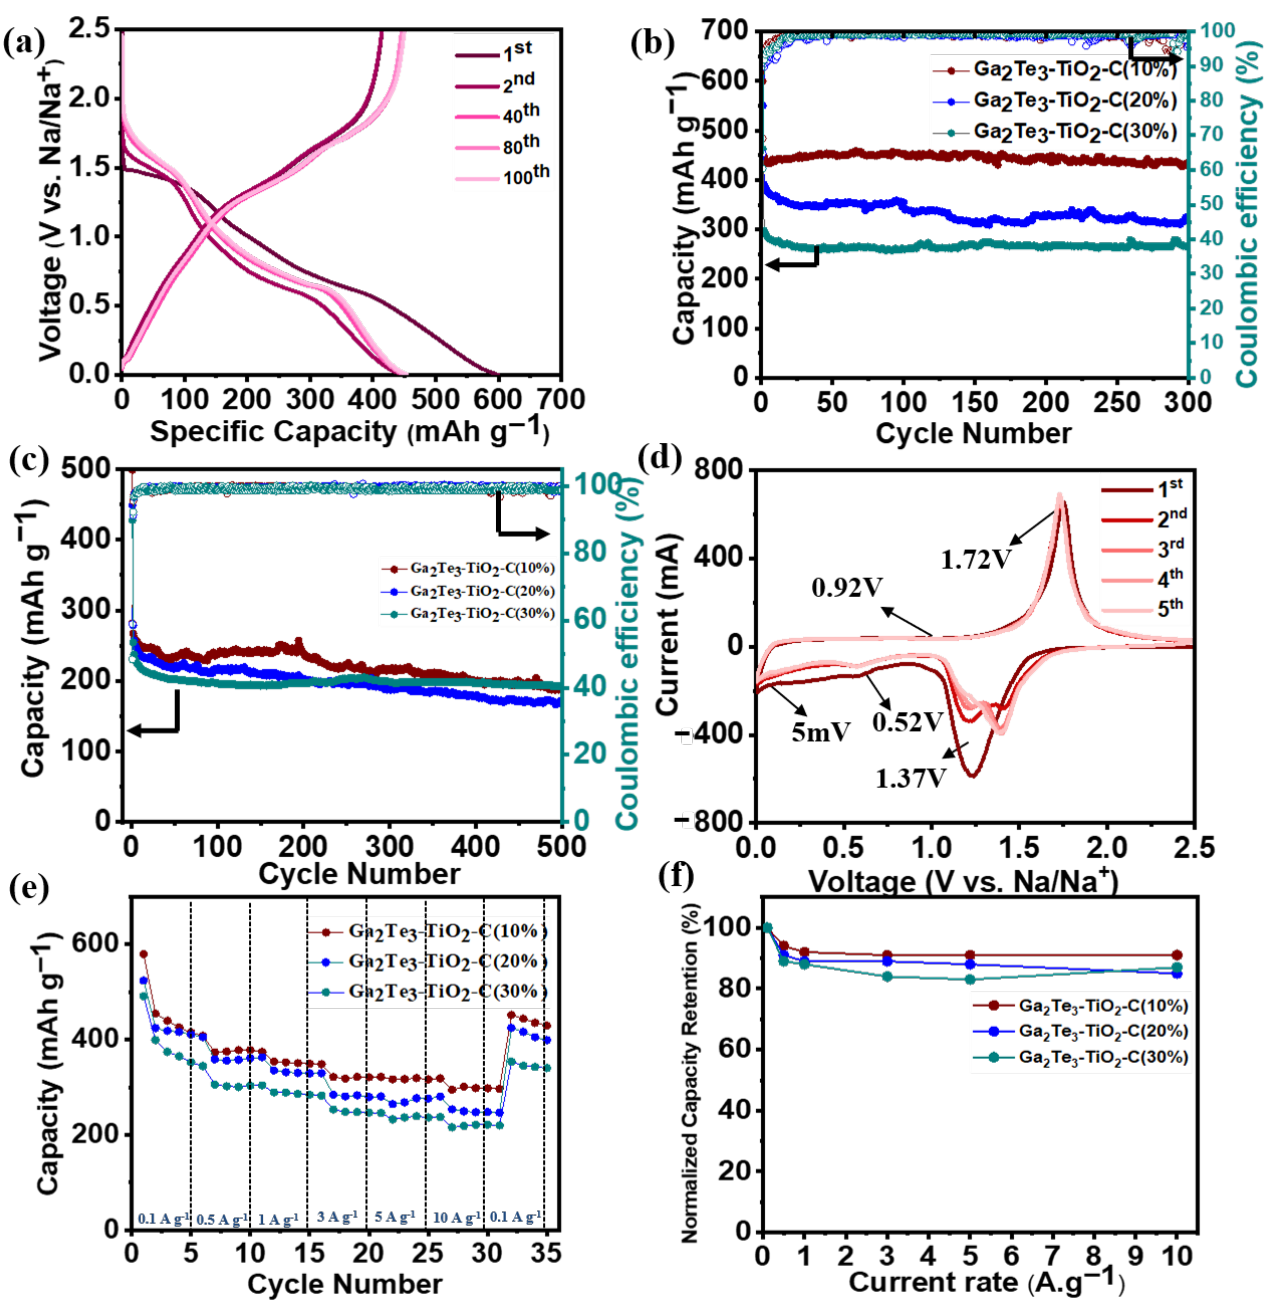
Figure 3. Electrochemical performances of Ga 2 Te 3 – TiO 2 – C composites for SIBs: ( a ) GCD profiles of Ga 2 Te 3 – TiO 2 – C(10%) at 100 mA·g −1 ; ( b ) cycling performances of composite at 100 mA·g −1 and ( c ) 500 mA·g −1 ; ( d ) CV curves of Ga 2 Te 3 – TiO 2 – C(10%); ( e ) rate capabilities of Ga 2 Te 3 – TiO 2 – C composites; ( f ) capacity retention of Ga 2 Te 3 – TiO 2 – C composites from 0.1 to 10 A·g −1 .